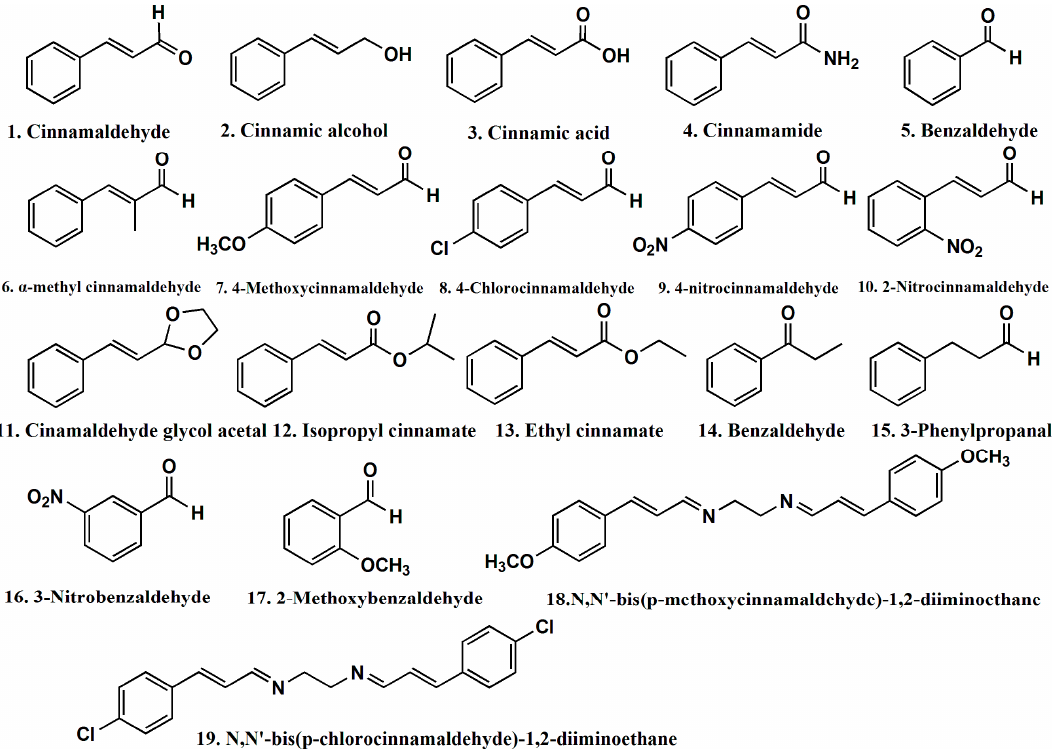
Figure 4. Structures of 19 cinnamaldehyde derivatives.